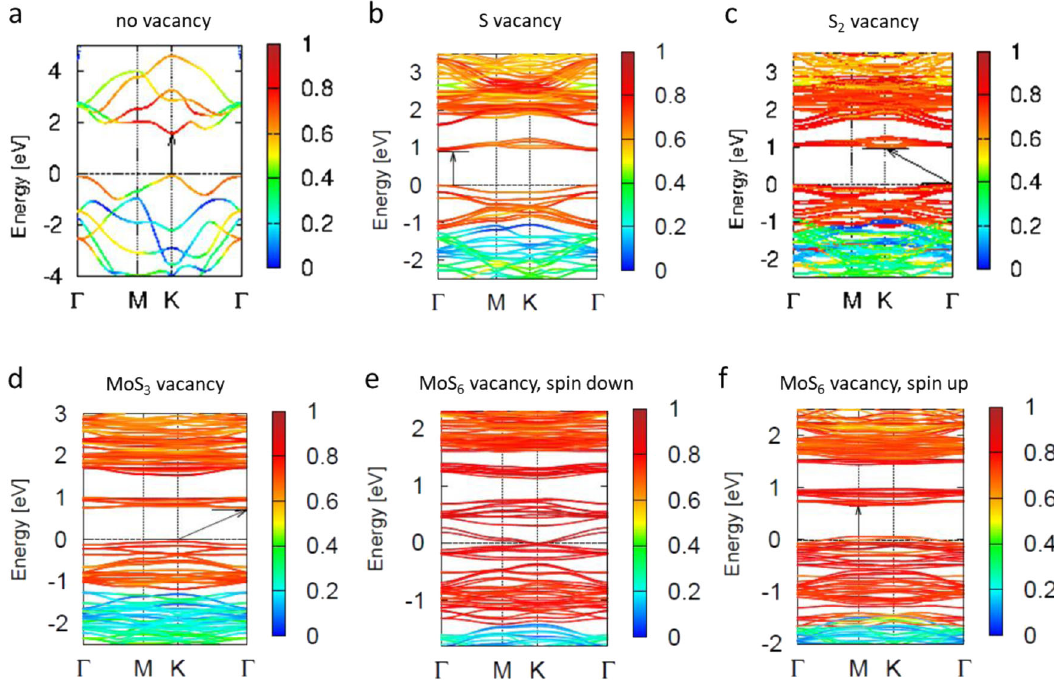
Fig. 5 Calculated band structures of mL MoS 2 without and with various atomic vacancies under no charge injection. a MoS 2 with no vacancy. b MoS 2 with the S vacancy. c MoS 2 with the S 2 vacancy. d MoS 2 with the MoS 3 vacancy. e , f MoS 2 with the MoS 6 vacancy for e spin-down and f spin-up case, respectively. When the electron doping is zero, no spin density or no magnetization is calculated for the cases of S, S 2 , and MoS 3 vacancies, as shown in Supplementary Fig. 4. These results are further con fi rmed by the existence of the bandgap at the Fermi level with no spin density as shown in b – d . For the MoS 6 vacancy, the bandgap is closed at the Fermi level depending on the spin direction as shown in e , f , which means a semimetal state. The color legend represents the projections of the bands on the Wannier functions localized at the Mo atoms.